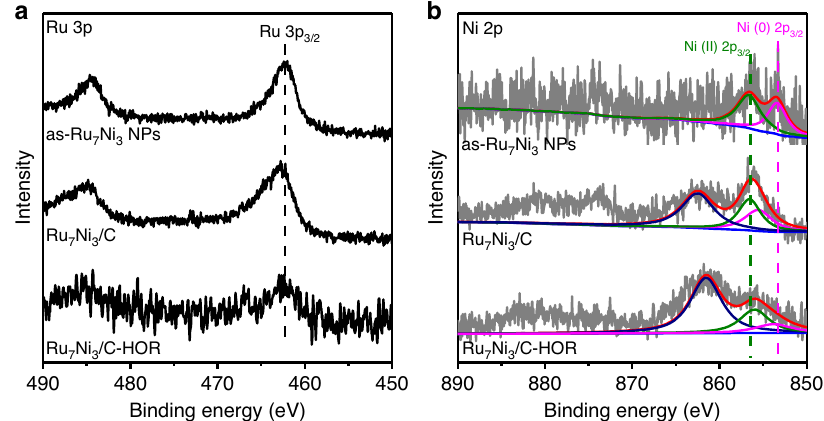
Fig. 4 High-resolution X-ray photoelectron spectra (XPS) spectra. a Ru 3p. b Ni 2p spectra of as-Ru 7 Ni 3 NPs, Ru 7 Ni 3 /C, and Ru 7 Ni 3 /C-HOR,